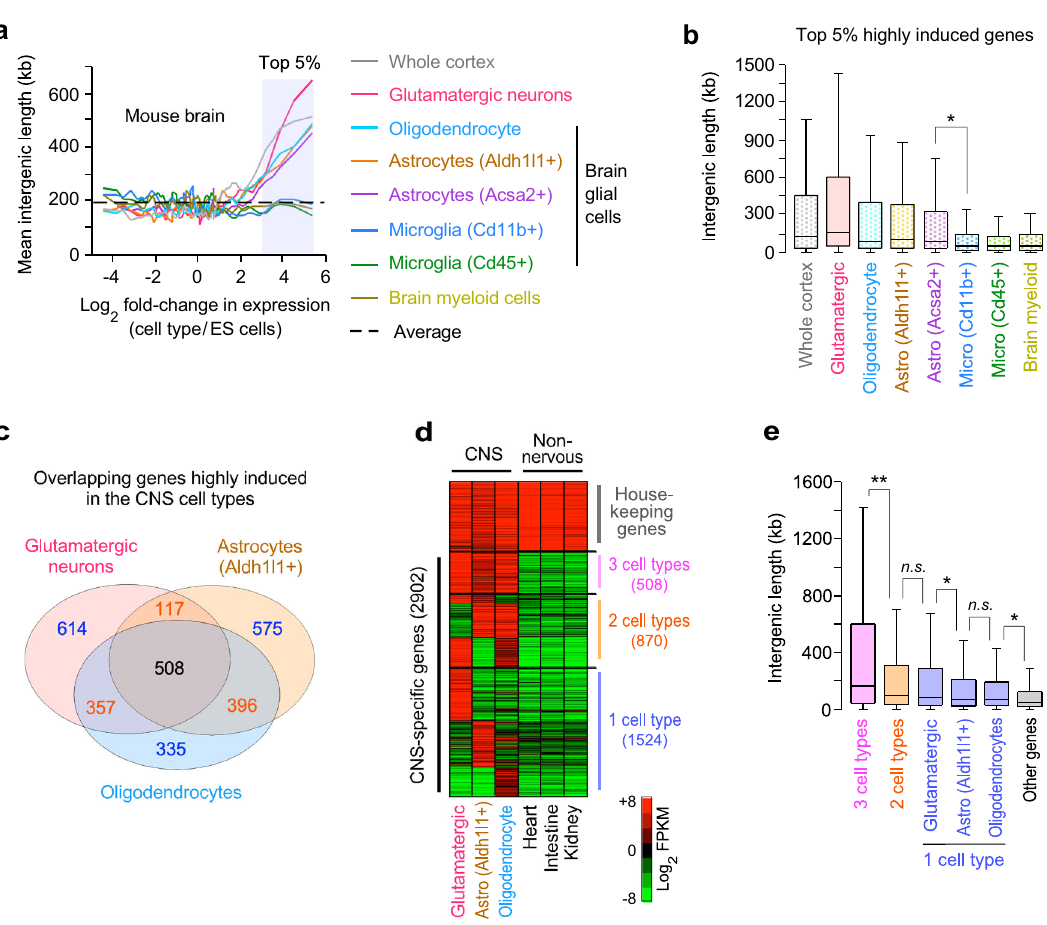
Fig. 2 Highly induced genes in neural supporting glial cells have extended intergenic lengths. a Genome-wide relationship between intergenic DNA lengths and gene induction levels in neurons and various glial cell types in the mouse brain. The lines represent the mean intergenic lengths for the genes, binned according to the gene induction level for each cell type compared to ES cells (log 2 fold-change in FPKM; 200 genes per bin; 18,383 mRNA genes; Supplementary Data 2). b Box plots of the intergenic DNA lengths of the top 5% highly induced genes in each cell type, out of all the mRNA genes (919 out of 18,383), shown in the shaded area in ( a ). The box plots indicate the median (line in a box), fi rst-to-third quartiles (boxes), and 1.5 × the interquartile range (whiskers). * P = 1.05 × 10 − 10 ; two-sided, two-sample t -test (Supplementary Data 3). c The Venn diagram of the overlap of highly induced genes (2902 in total) between 3 CNS cell types (glutamatergic neurons, astrocytes, and oligodendrocytes) in mice. The top 10% highly induced genes in each cell type, out of all the mRNA genes, were used. 508 genes were induced in all 3 CNS cell types (Supplementary Methods). d Expression levels of 755 housekeeping (HK) genes and 2902 genes, based on the Venn diagram analysis in ( c ), in the 3 CNS cell types and 3 non-neural tissues (the mouse 8-week heart, intestine, and kidney). The HK genes were induced >2-fold compared to ES cells in all 6 cell types. 870 genes were induced in 2 CNS cell types and 1524 genes were induced in only 1 CNS cell type. The FPKM values were median normalized and log 2 transformed (Supplementary Data 5). e Box plots of the intergenic DNA lengths of the groups of genes (2902 genes) de fi ned in ( c , d ) and all other genes (13,817 genes). The box plots show the median (line in a box), fi rst-to-third quartiles (boxes), and 1.5 × the interquartile range (whiskers). ** P = 3.93 × 10 − 6 ; * P < 3.70 × 10 − 3 ; n.s ., non-signi fi cant P > 0.44; two- sided, two-sample t